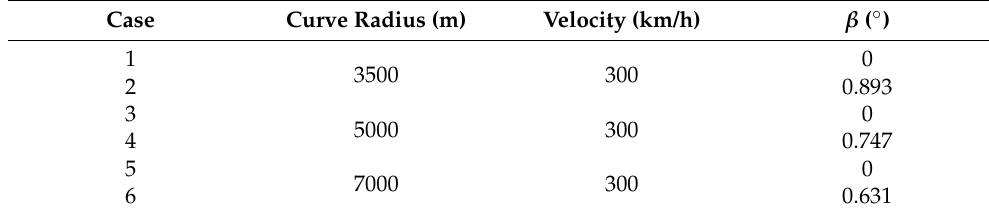
Table 7. Impact simulation conditions.